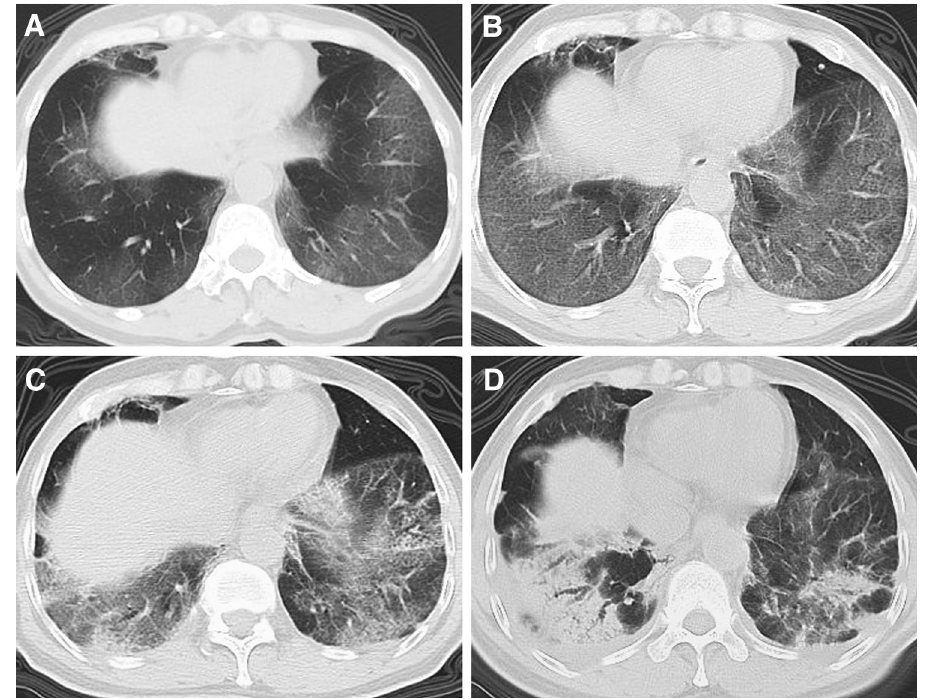
Figure 4. CT findings of a representative COVID-19 patient in discharge group who presented with fever and mild dyspnea, severe pneumonia, and gradually improved in symptoms corresponding to the CT scans. (A) Scan obtained on illness day 4 shows multifocal ground-glass opacities in double lower lobes, with a subpleural distribution. (B) Scan obtained on illness day 7 shows that the ground-glass opacities were increased, with superimposed interlobular and intralobular septal thickening and with diffuse distribution. (C) Scan obtained on illness day 12 shows that the ground-glass opacities were decreased, with superimposed irregular opacities. (D) Scan obtained on illness day 23 shows development of a mixed